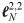
The exact differences Φ(r) − Φ0(r) for the graphs ℓN2,2.(A) Even orders. (B) Odd orders. Initial evolutionary regimes are distinguishable from the graphs of the functions Φ(r) − Φ0(r) associated to the graphs ℓN2,2 when N varies from 6 to 15, while transitions can be observed in the zoomed images. The exact places of transitions are specified in S2 Table.